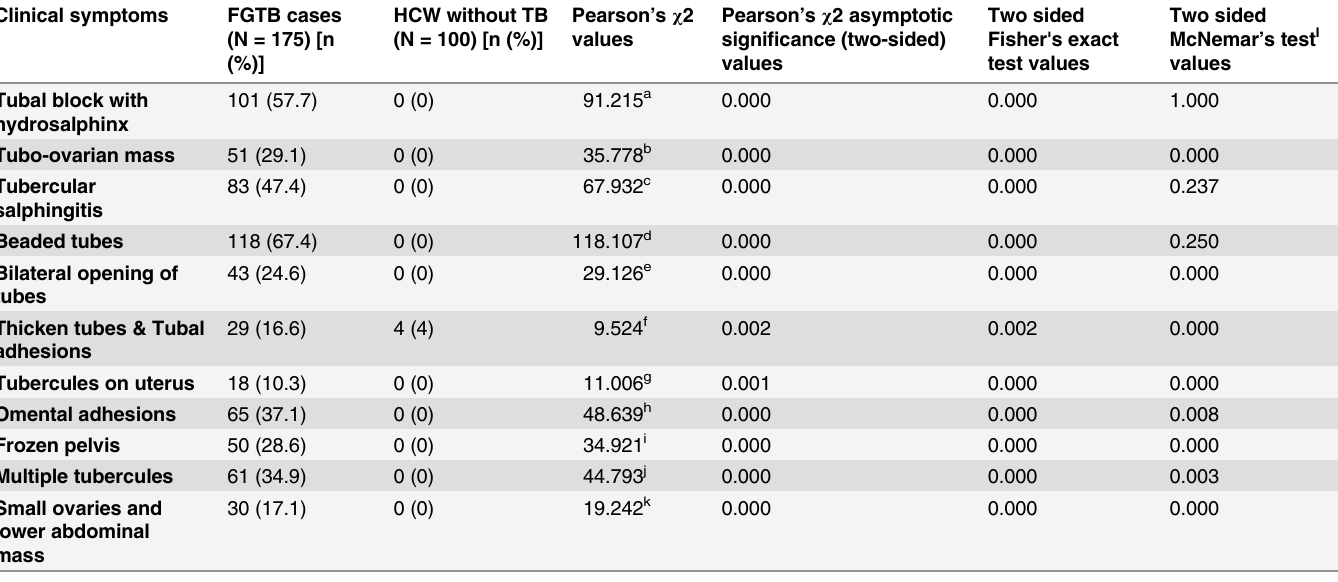
Table 5. Statistical association of laparoscopic findings among infertile women with FGTB and HCW without TB. Clinical